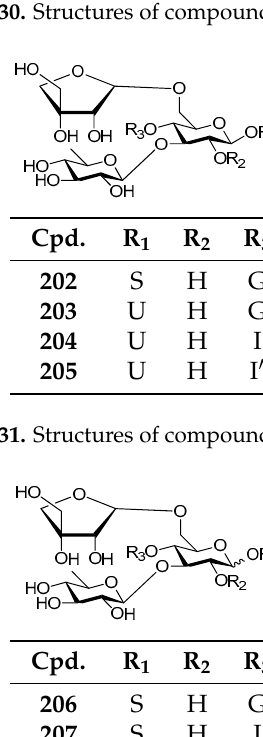
Figure 32. Structures of compounds 206 – 207 .